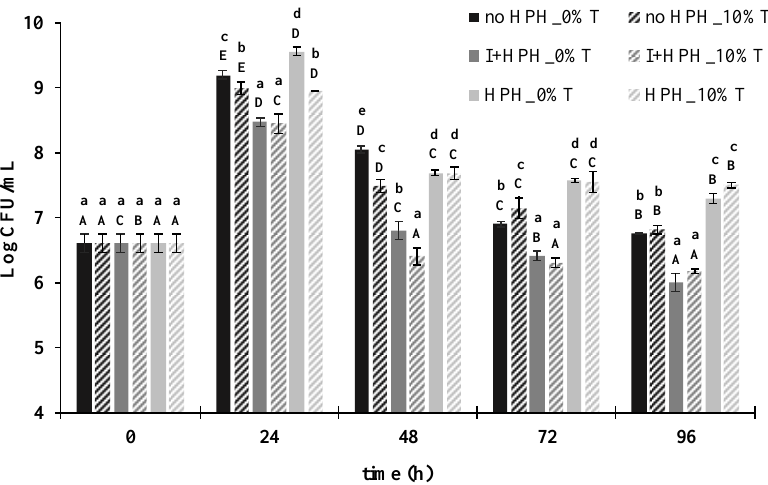
Figure 1. Microbial counts in clementine juice subjected to different treatments along their fermenta- tion with L. salivarius spp. salivarius CECT 4063 for 4 days. Error bars represent the standard deviation of 4 replications. a–e In the same time and A–D in the same series indicate statistically significant difference with a 95% confidence level ( p <